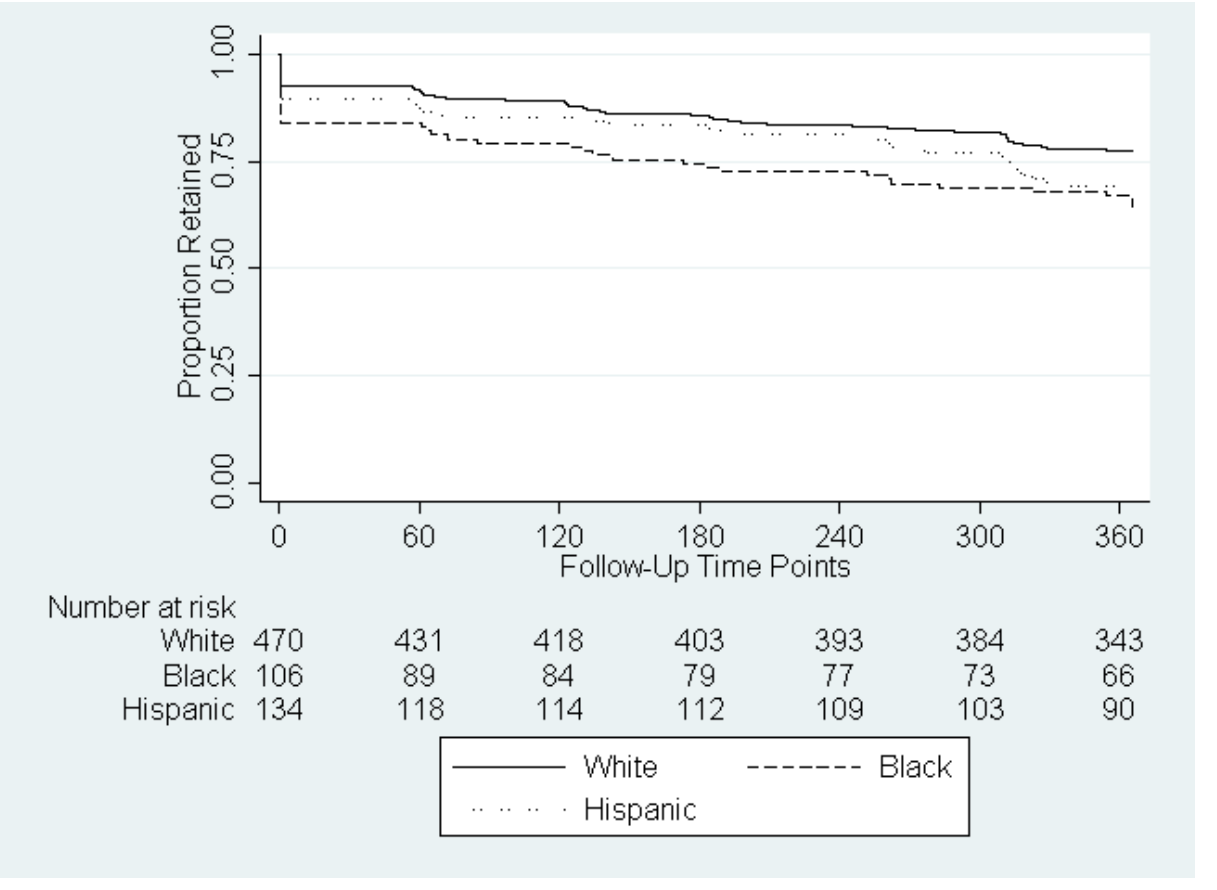
Figure 3. Retention of participants in an online study, by race/ethnicity (N=710).